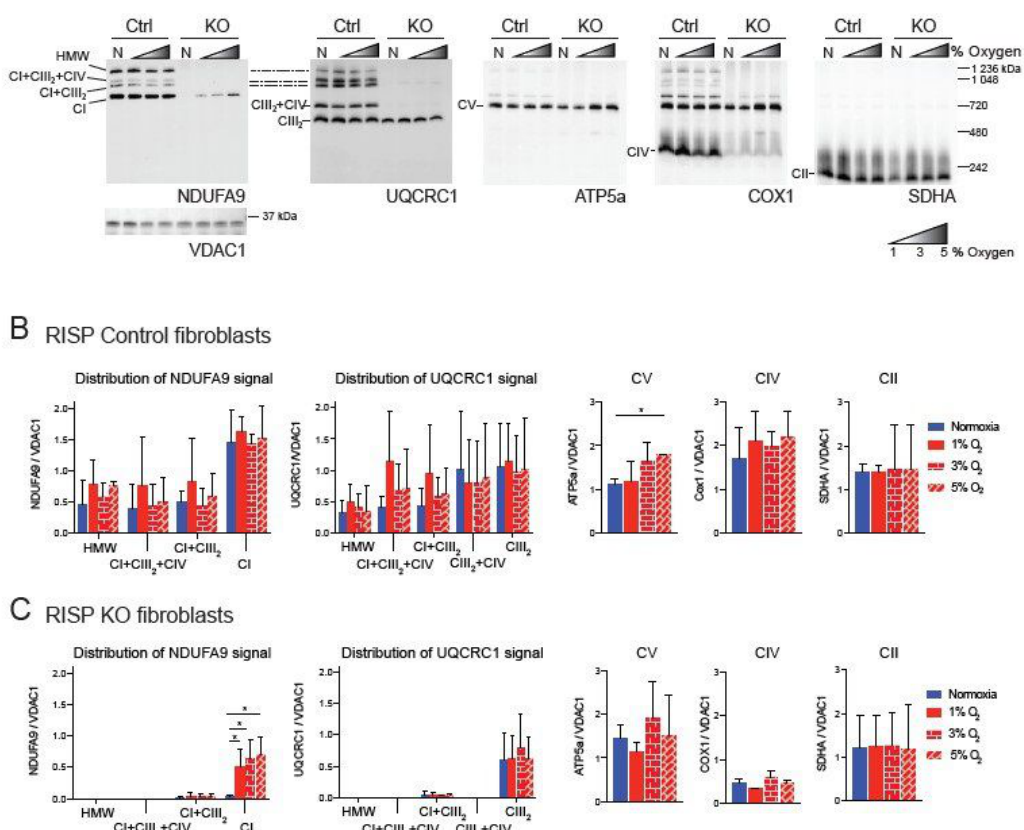
Figure 1. Blue native gel electrophoresis of Rieske iron sulfur protein (RISP) murine fibroblasts exposed to di ff erent oxygen concentrations. ( A ) RISP control and KO lung fibroblasts were exposed to normoxia (N, 21% oxygen), 1, 3 and 5% oxygen for 24 h. Mitochondrial proteins were extracted with digitonin and oxidative phosphorylation (OXPHOS) complexes and supercomplexes (SCs) analyzed by blue native gel electrophoresis (BN-PAGE) followed by Western blot using antibodies against respiratory complex subunits. Shaded triangles represent hypoxic conditions of increasing oxygen concentrations (1, 3 and 5% oxygen). Antibodies were sequentially added in two identical blots in the following order, in blot 1: NDUFA9 (complex I (CI) subunit), ATP5A (complex V (CV) subunit) and COX1 (complex IV (CIV) subunit) and SDHA (complex II (CII) subunit), in blot 2: UQCRC1 (complex III (CIII) subunit). The positions of each respiratory complex (CI-CV) and SCs, as well as molecular weights, are indicated in the figure. SCs include high molecular weight (HMW), CI + CIII 2 + CIV, CI + CIII 2 , and CIII 2 + CIV architectures. ( B ) Quantification of antibody signals and distribution into complexes and SCs of control lung fibroblasts shown in ( A ) of NDUFA9, UQCRC1, ATP5A, COX1 and SDHA normalized to the mitochondrial loading control VDAC1. Optical density was calculated using the ImageJ software. Graphs represent mean and standard deviation ( n = 3). Statistical di ff erences among groups was calculated using one-way ANOVA analysis followed by Tukey’s multiple comparisons test where * p < 0.05 was considered statistically significant. Blue bars represent normoxia, red bars represent 1% O 2 , red horizontal brick pattern bars represent 3% O 2, and red diagonal brick pattern bars represent 5% O 2 . ( C ) Quantification of antibody signals in RISP KO fibroblasts ( n = 3) as described in ( B ). Antibodies were sequentially added on two identical blots in the following order, on blot 1: NDUFA9, ATP5A, COX1, and SDHA, on blot 2: UQCRC1 and SDHA. Exposure to 1–3% oxygen increased the levels of CI and CI + CIII 2 in COX10 KO fibroblasts. Exposure to hypoxia significantly increased the levels of CI in RISP KO